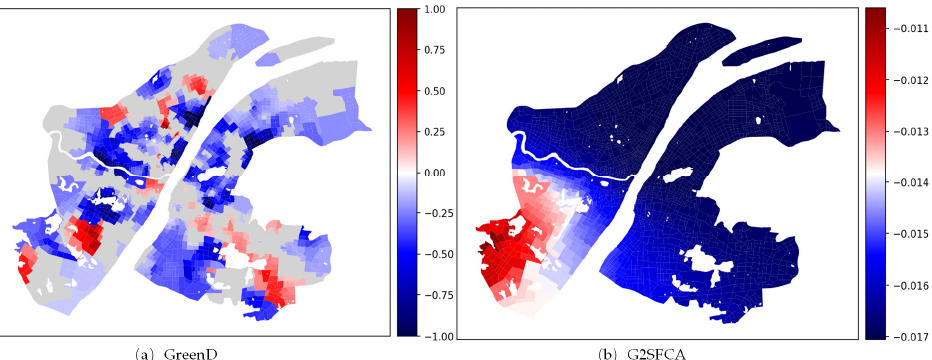
Figure 8. Multiscale effect of green space accessibility. ( a ) Distance to nearest green space, ( b ) Green space accessibility calculated by 2SFCA .